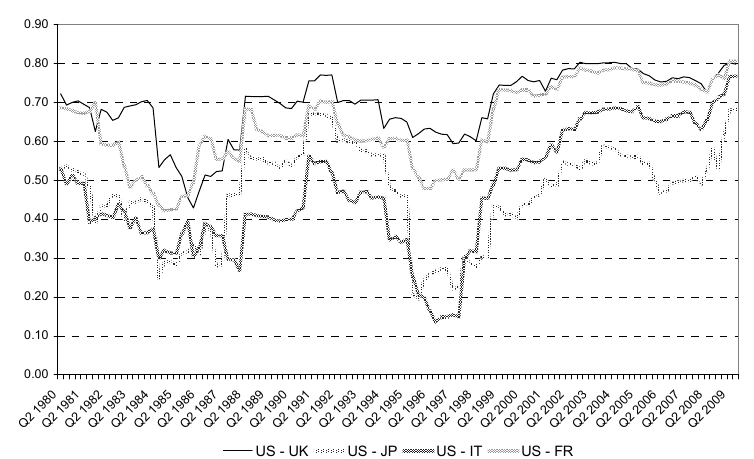
Figure 2 – Dynamics of conditional correlation coefficients estimated by the DCC MV-GARCH between the U.S. and the other countries.